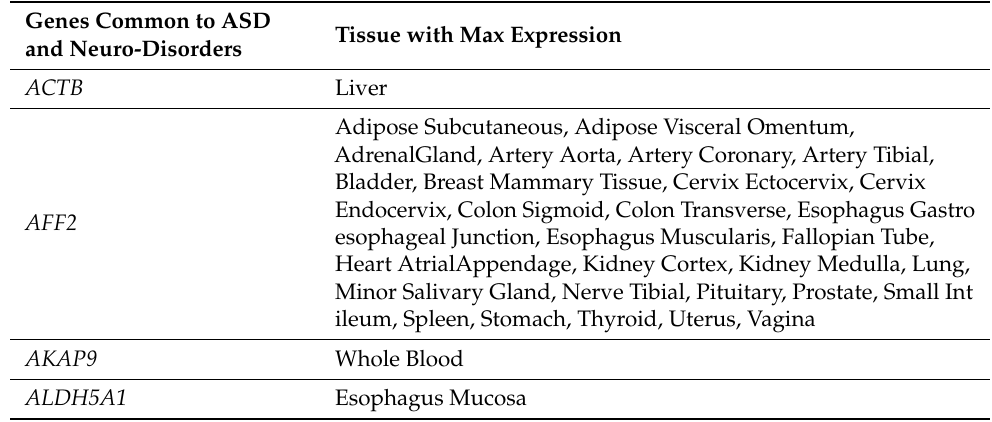
Table 3. Compact set of genes common to Autism and the neurological and neuropsychiatric disorders maximally and selectively expressed across the 54